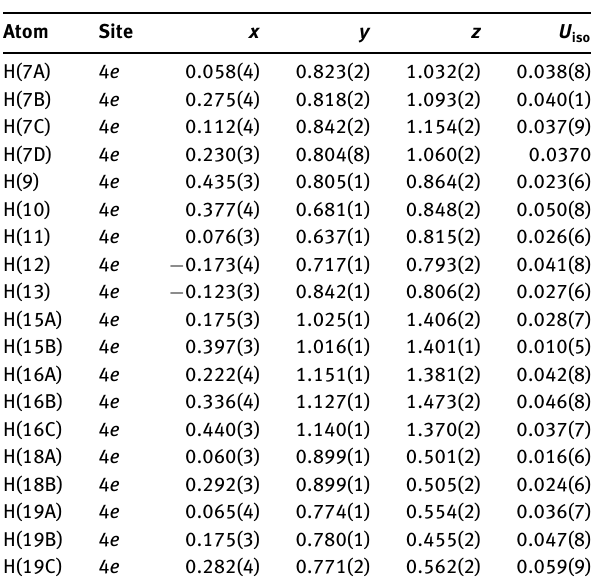
Table 2: Fractional atomic coordinates and isotropic or